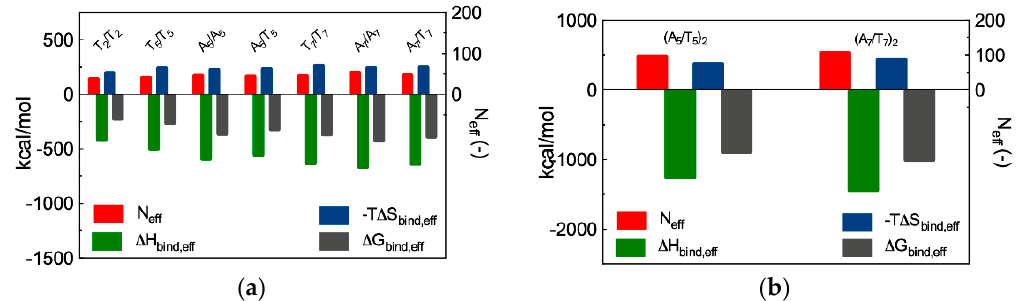
Figure 11. Total effective free energy ( Δ G bind,eff = Δ H bind,eff –T Δ S bind,eff ), enthalpic ( Δ H bind,eff ), and entropic (–T Δ S bind,eff ) components for the binding of ( a ) ssiRNAs featuring complementary and non-complementary overhangs of different length and ( b ) dimeric ssiRNAs with the G 5 TEA-core PAMAM dendrimer. N eff is the number of effective dendrimer positive charges involved in nucleic acid binding (see Tables A1 and A2 in Appendix A and text for more details). ( b ) Redrawn from [57], with permission of the American Chemical Society.